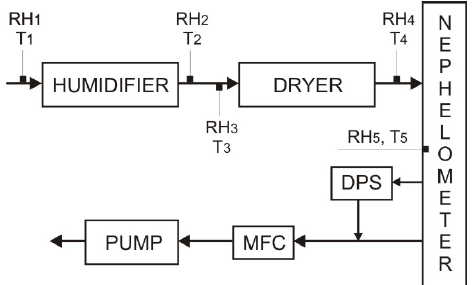
Figure 26. Schematic diagram of a humidified three-wavelength integrating nephelometer (DPS: dew point sensor; MFC: mass flow controller). Reprint with permission by Fierz-Schmidhauser et al.